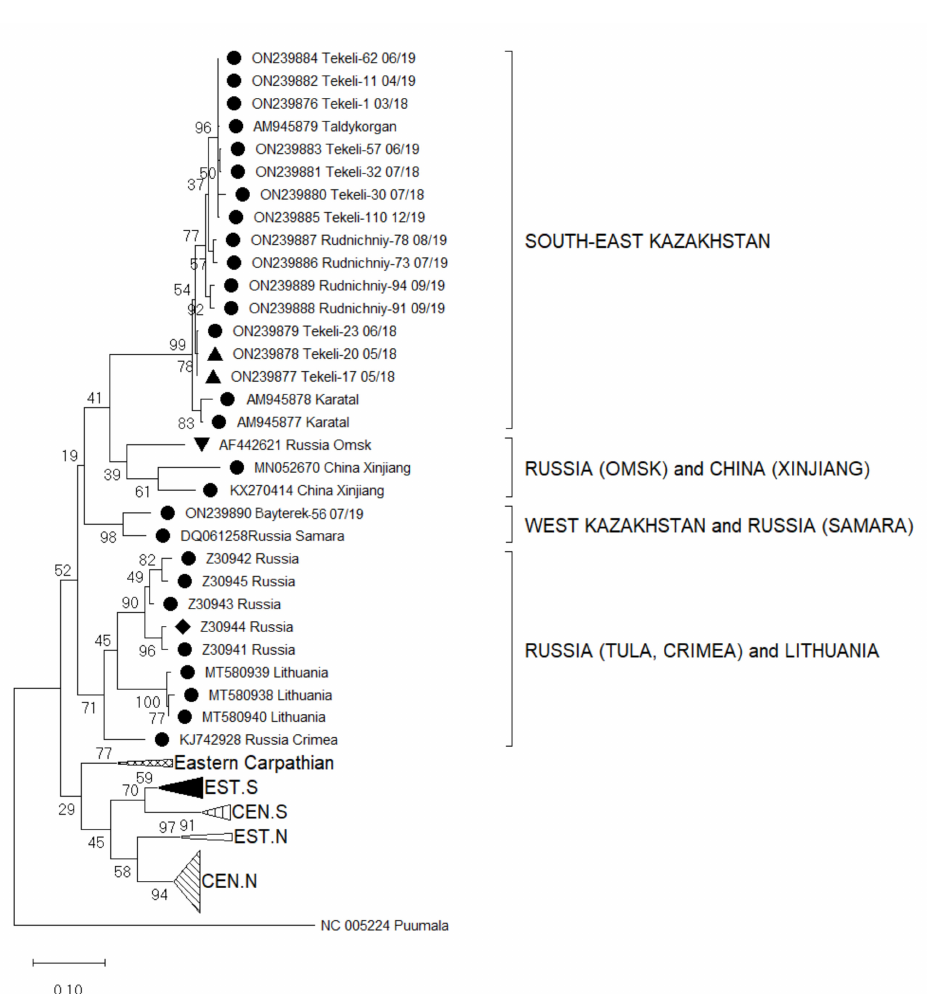
Figure 2. Phylogenetic analysis by Maximum Likelihood method of the S segments (346 nucleotides (nt), positions of sequences 715–1061 nt in regard to the reference sequence AM945879) of Tula virus in Kazakhstan. The tree with the highest log likelihood ( − 5756.38) is shown. The percentage of trees in which the associated taxa clustered together is shown next to the branches. This analysis involved 92 nucleotide sequences: Central North (CEN.N): KU139579, KU139576, KU139577, KU139578, DQ662094, HQ697346, HQ697344, HQ697347, HQ697351, GU300137, GU300136, EU439952,